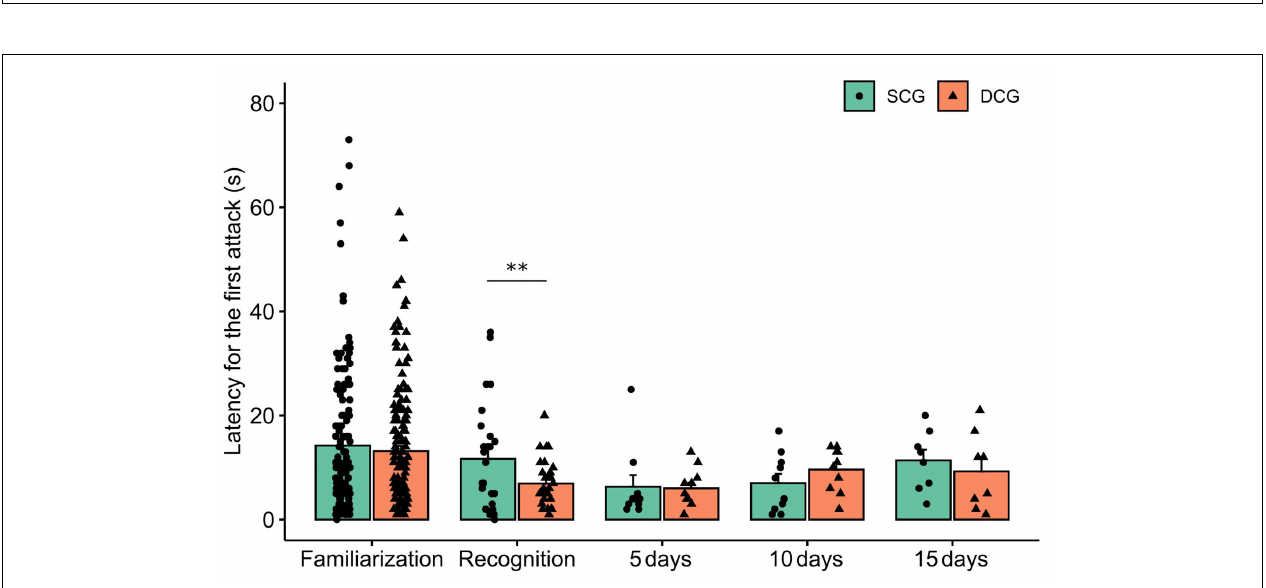
FIGURE 2 | Total agonistic displays in each experimental phase. Bars (Mean + SE) indicate total agonistic displays of the dusky damselfish Stegastes fuscus for 10 min. Different uppercase letters indicate statistical significance in the SCG (two-way ANOVA, p < 0.05). Different lowercase letters indicate statistical significance in the DCG (two-way ANOVA, p < 0.05). An asterisk indicates a statistical difference between the SCG and DCG, in the same experimental phase ( p < 0.05). Post hoc showed statistical significance between the SCG and DCG and SCG 5 and DCG 5 ( p = 0.01) during the recognition test ( p = 0.01).